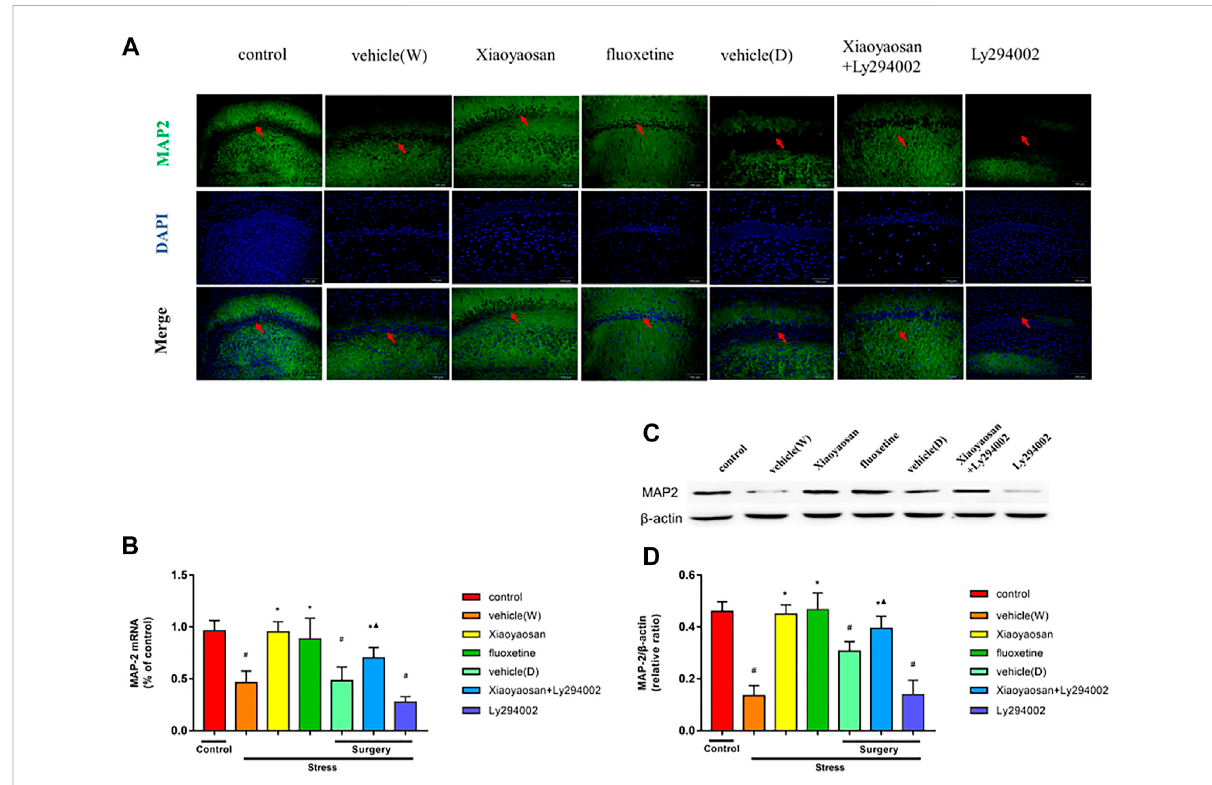
FIGURE 5 Xiaoyaosan elevates the expression of MAP2 in the hippocampal CA1 region of CUMS rats ( A , original magni fifi cation, ×200) Xiaoyaosan and Xiaoyaosan + Ly294002 promoted MAP2 expression in the CUMS rats. The green color represents MAP2 staining, and the blue color represents nuclear staining (C) Representative images and western blot analysis (D) of western blot assay showing the relative expression of MAP2 (B) Level of MAP2 mRNA in the hippocampal CA1 area of the rats in the treatment and control groups. All data are expressed as the mean ± SD. # p < 0.05 compared to the control group; * p < 0.05 compared to the vehicle (W) group; ▲ p < 0.05 compared to the Ly294002 group, n =